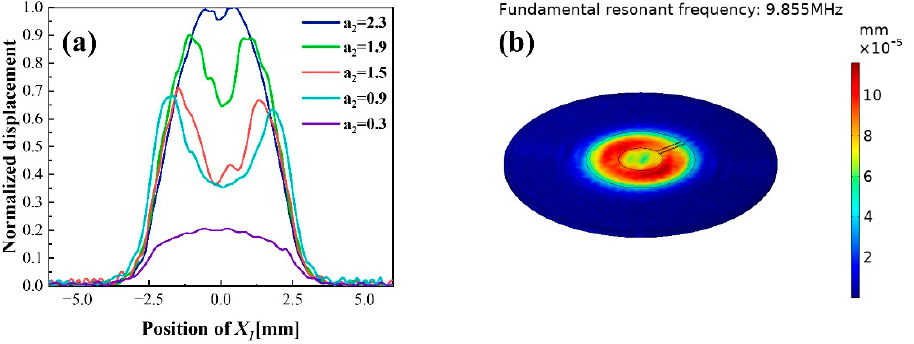
Figure 4. The vibration displacement in X 1 direction of QCM with single finger electrode: ( a ) Normalized displacement distribution on electric shaft X 1 with different finger width a 2 (mm); ( b ) Vibration displacement nephogram when a 2 is 1.5